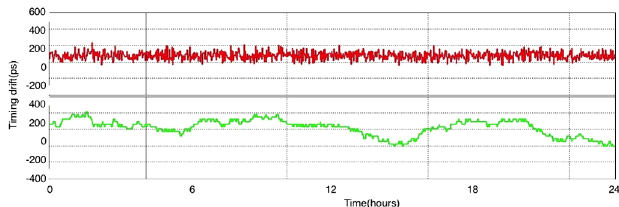
FIG. 9. Output timing feedback: the fine delay setting (green) and the output timing (red).